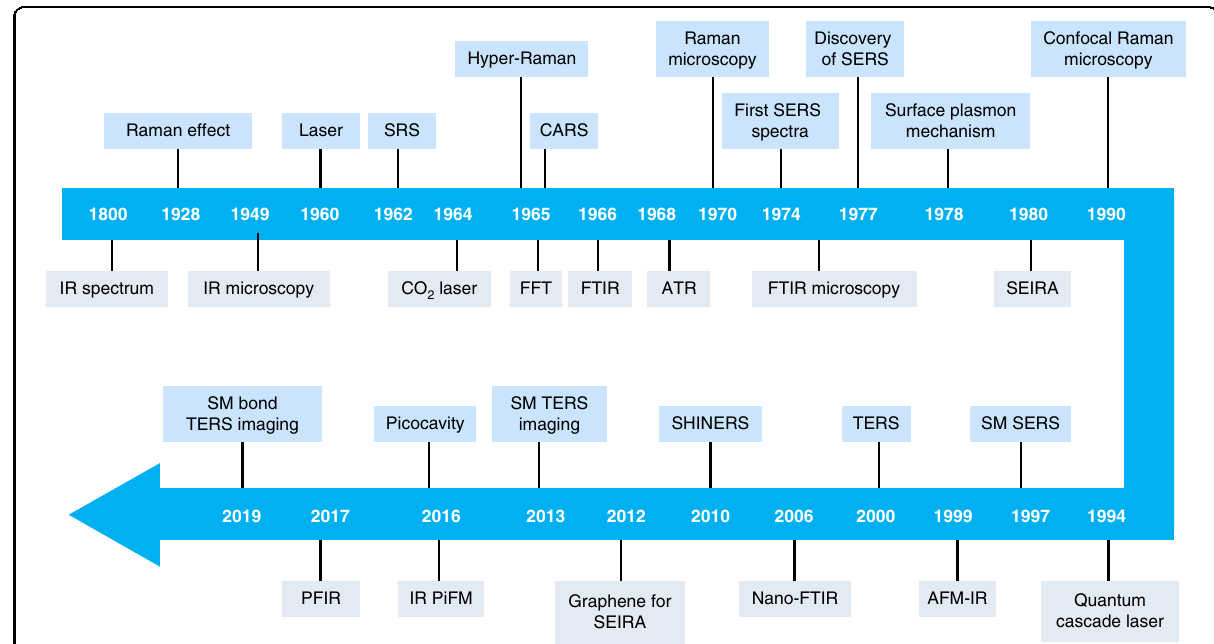
Fig. 1 A timeline of historical advances in SERS, SEIRA, and related techniques. SRS stimulated Raman scattering, Hyper-Raman Hyper-Raman scattering, CARS coherent anti-Stokes Raman scattering, FFT fast Fourier transform, FTIR Fourier transform infrared spectroscopy, ATR Attenuated total re fl ectance, SEIRA surface-enhanced infrared absorption spectroscopy, SM single molecule, TERS tip-enhanced Raman spectroscopy, SHINERS shell- isolated nanoparticle-enhanced Raman spectroscopy, PFIR, peak force infrared microscopy, IR PiFM, infrared photoinduced force microscopy, Nano- FTIR Fourier transform infrared nanospectroscopy, AFM-IR Atomic force microscopy-based infrared